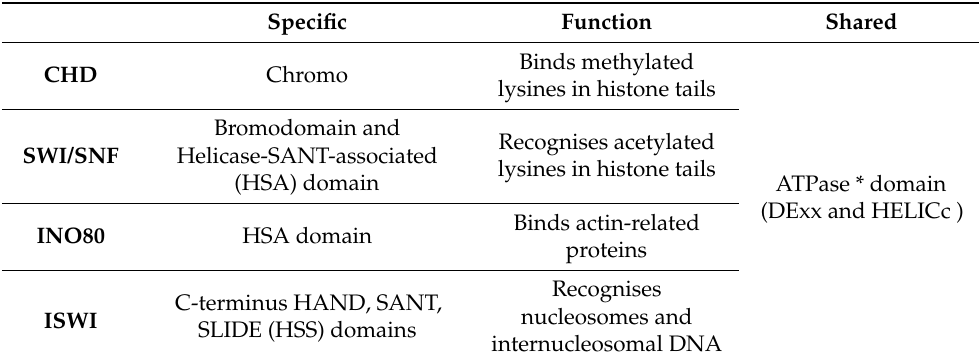
Table 1. Main types of ATP-dependent chromatin